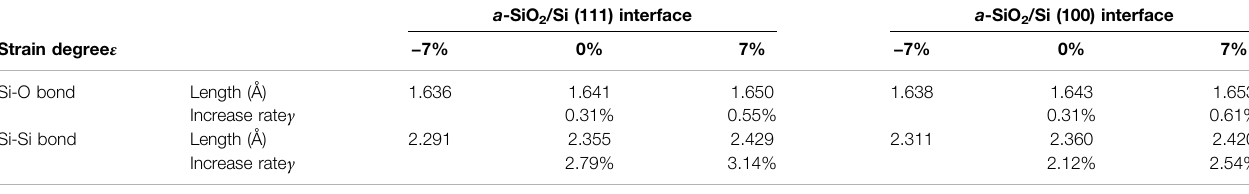
a -SiO 2 /Si (111) interface